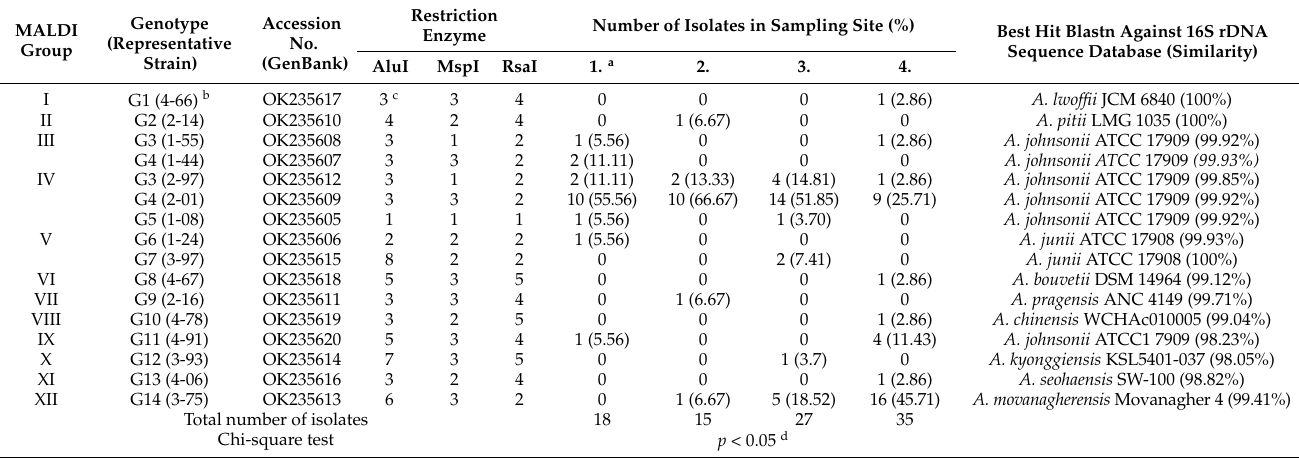
Table 3. Variability of Acinetobacter community in wastewater treatment plant in Kokšov-Bakša for Košice city (Slovakia) based on MALDI-TOF MS, ARDRA and 16S rDNA sequence analysis.